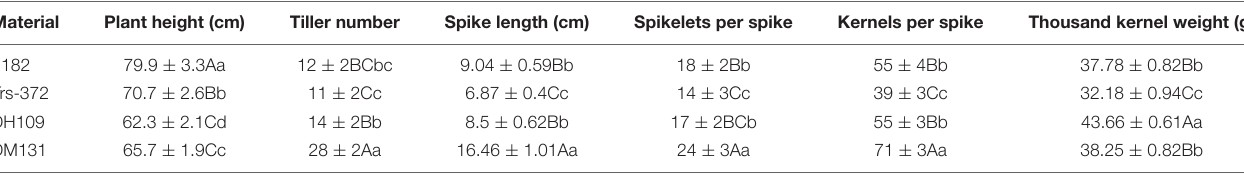
TABLE 4 | Morphological traits of common wheat 7182, durum wheat Trs-372, DH109, and DM131. Material Plant height (cm)